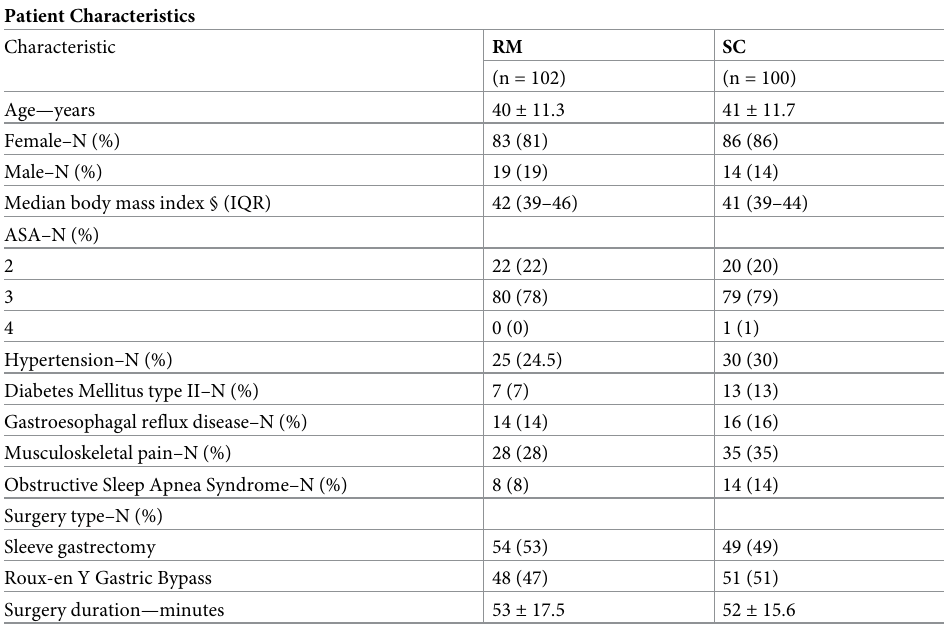
Table 1. Patient characteristics. Patient Characteristics